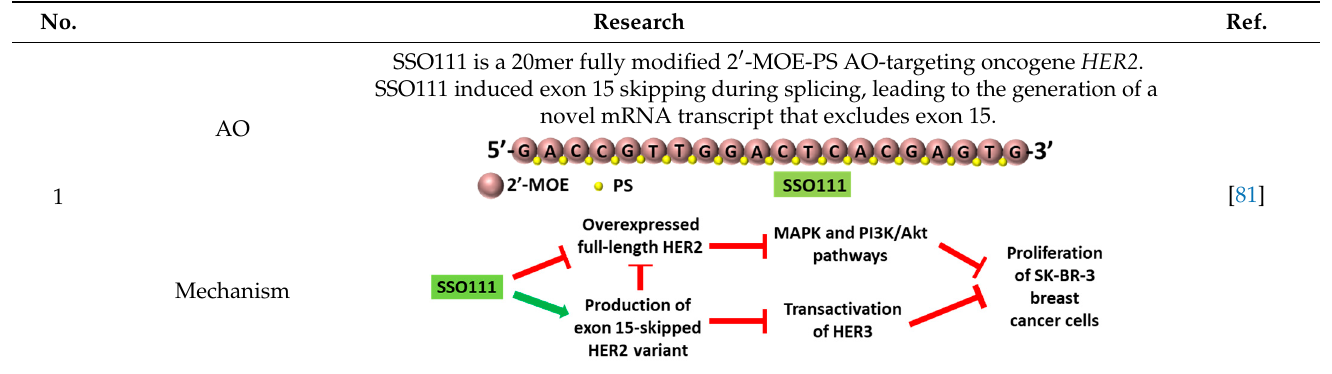
Table 1. Schematic representation of the six distinct studies on developing splice-modulating AOs targeting cancers. Among these AOs, ( 1 ) SSO111, ( 2 ) Acr-PNA 2794, (3) SSOe26, and ( 6 ) morpholino MDM4 inhibited overexpression of oncogenes by inducing exon skipping, thus producing non-functional variants or leading to nonsense-mediated decay (NMD) of mRNA, while ( 5 ) PNA 4577, 4578, 4580 and 4581 predominantly induced intron retention, resulting in the production of non-functional variants. Besides, ( 4 ) ASWT1exon5 induced RNase H-mediated degradation of longer transcripts, thus increasing the proportion of naturally occurring, shorter transcripts which exclude an important exon. 2 ′ -MOE, 2 ′ -O-methoxyethyl; 2 ′ -OMe, 2 ′ -O-methyl; PNA, peptide nucleic acid; LNA, locked nucleic acid; PS, phosphorothioate; PMO, phosphorodiamidate morpholino oligomer.